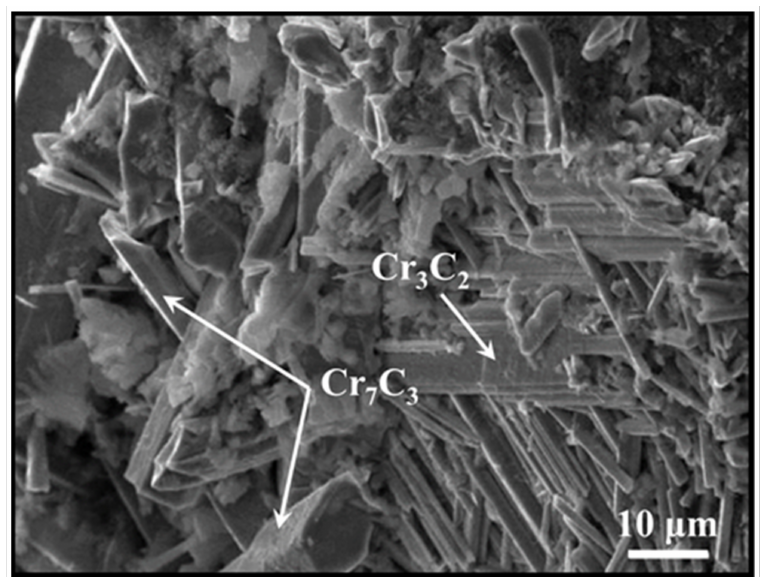
Figure 7. SEM micrographs of reaction products formed at the surfaces of the brazed diamonds. Reprinted with permission from Ref. [46]. Copyright 2019, Elsevier.